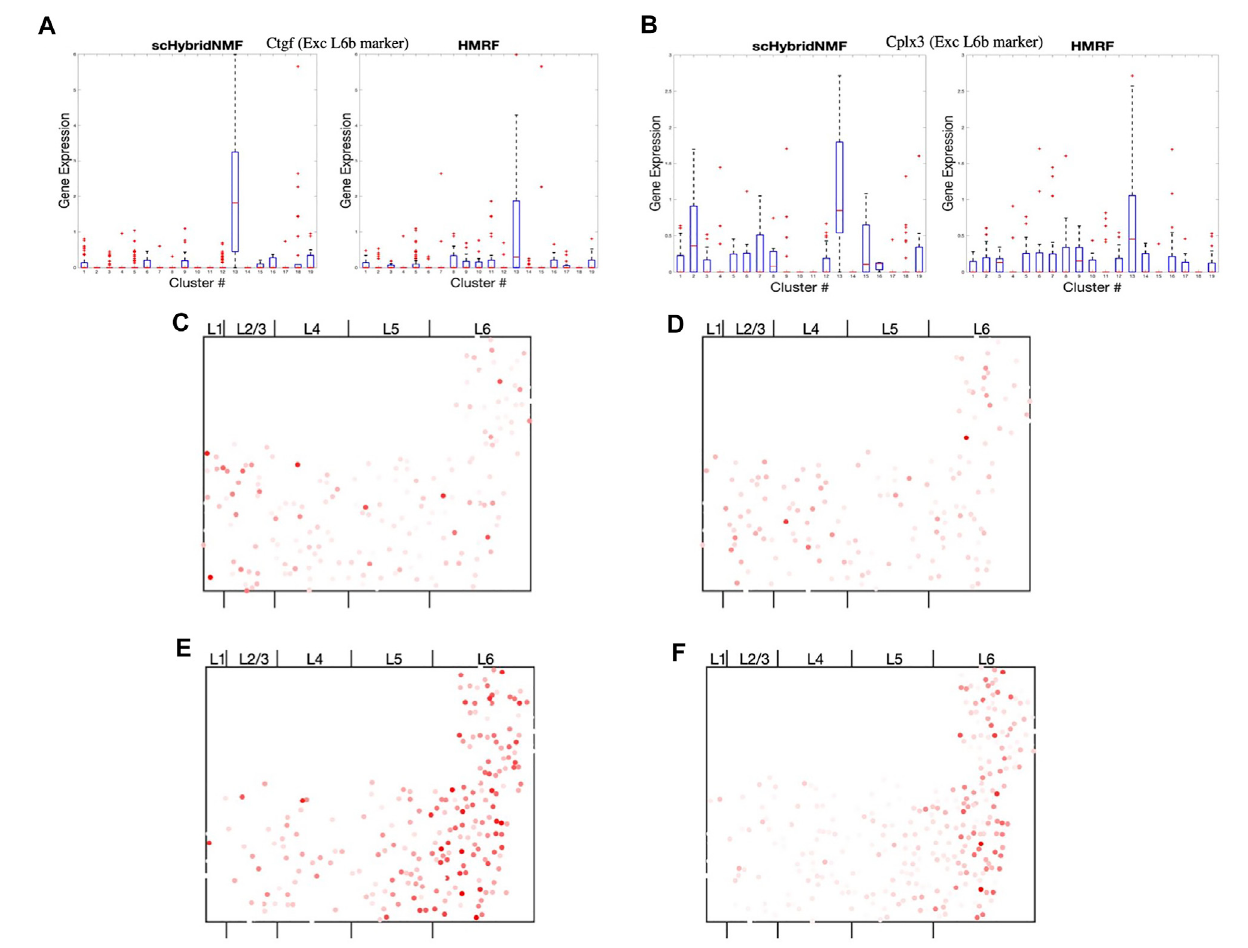
FIGURE6|(A,B) BoxplotsoftheexpressionsofCtgfandCplx3acrosseachcell,groupedbycluster. (C,D) DotplotsoftheexpressionsofCpne2andPtgfracross each cell. These genes are marker genes of L5a and L5b excitatory neurons (Tasic et al., 2016). (C) Cpne2 (L5a marker). (D) Ptgfr (L5b marker). (E,F) Dot plots of the expressions of Islr2 and Rprm across each cell. We propose Islr2, a DE gene recovered through Scran on scHybridNMF clusters, as a marker gene for L6 excitatory neurons. We show the expression of Rprm as a baseline. (E) Islr2 (scHybridNMF). (F) Rprm (L6a, Tasic, et al ).